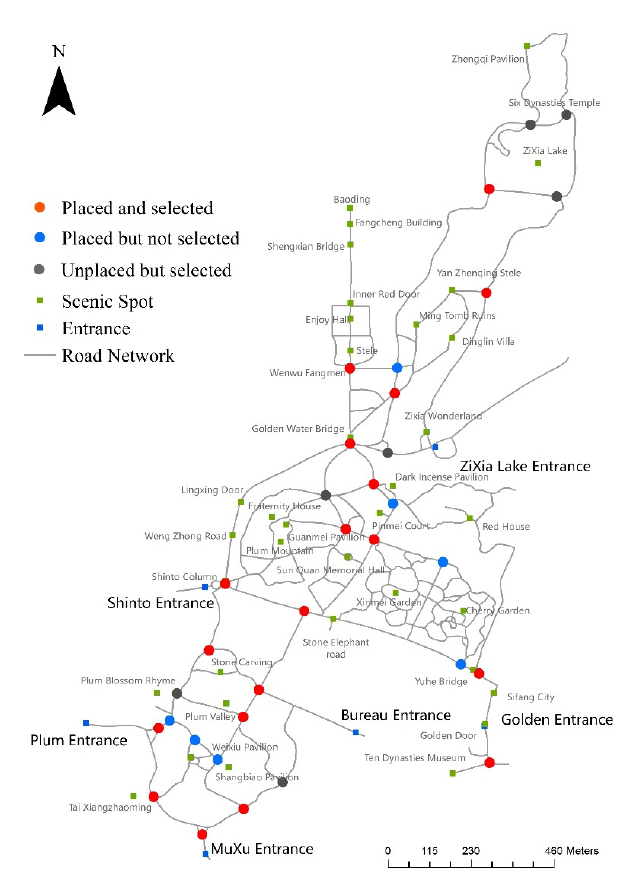
Figure 12. Comparison of two placement schemes when the number of selected nodes limited to 26.